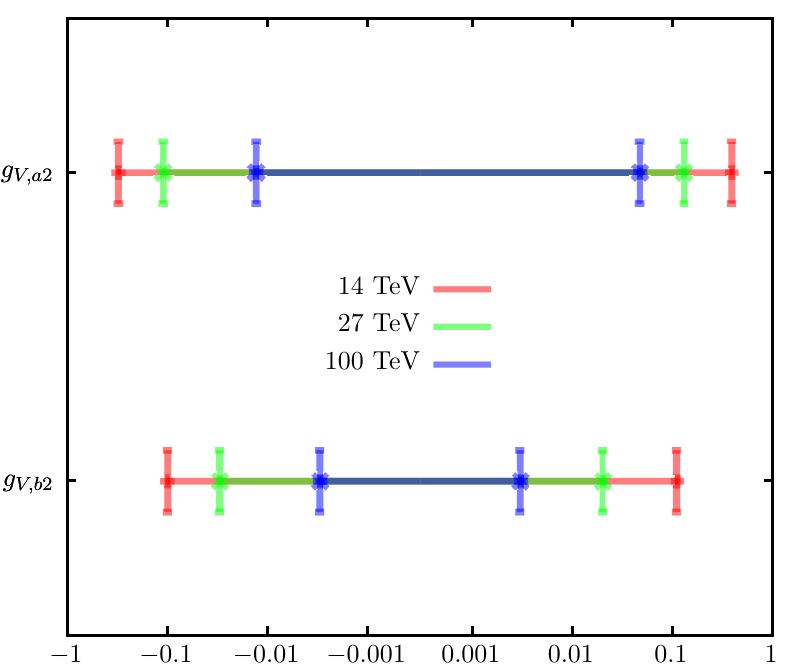
Figure 11 . The summarized bounds of g V,a 2 and g V,b 2 at 14 TeV, 27 TeV and 100 TeV hadron collider, which is the same as table